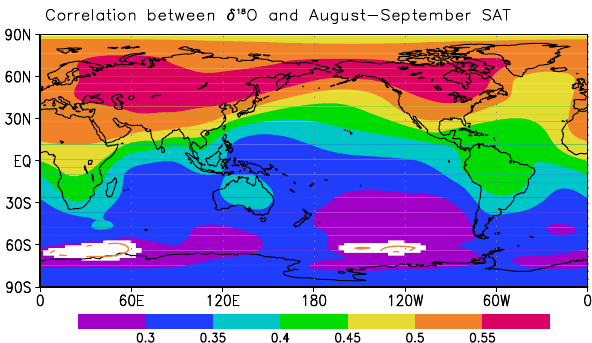
Fig. 10 . Correlation coefficients between the Guliya δ 18 O - temperature proxy Fig. 10. Correlation coefficients between the Guliya δ 18 O- temperature proxy record and the simulated August–September record and the simulated August–September SAT with the 1308 samples. The SAT with the 1308 samples. The shading indicates the correlation shading indicates the correlation coefficients significant at the 95% confidence coefficients significant at the 95% confidence level. level. fifth peaks (valleys) and the sixth peak of the Guliya SAT